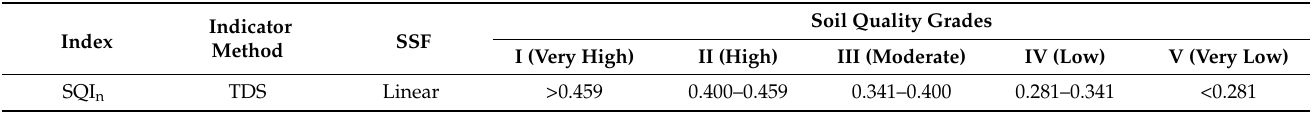
Table 2. Soil quality grade classification for indices and indicator